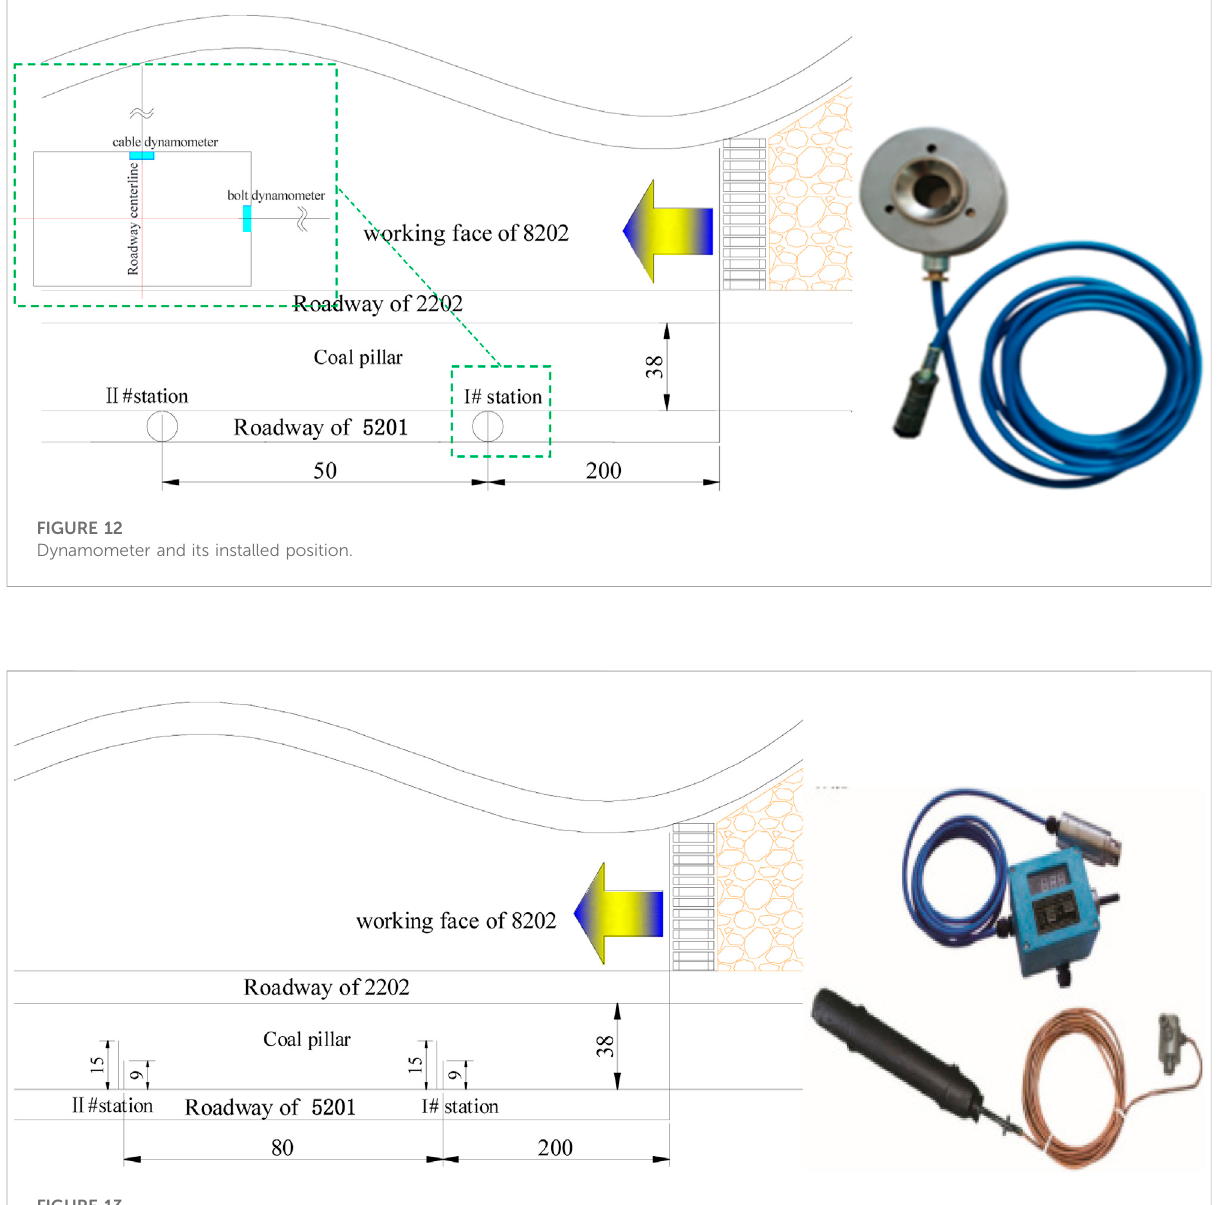
FIGURE 13 Rock stress sensor and its installed